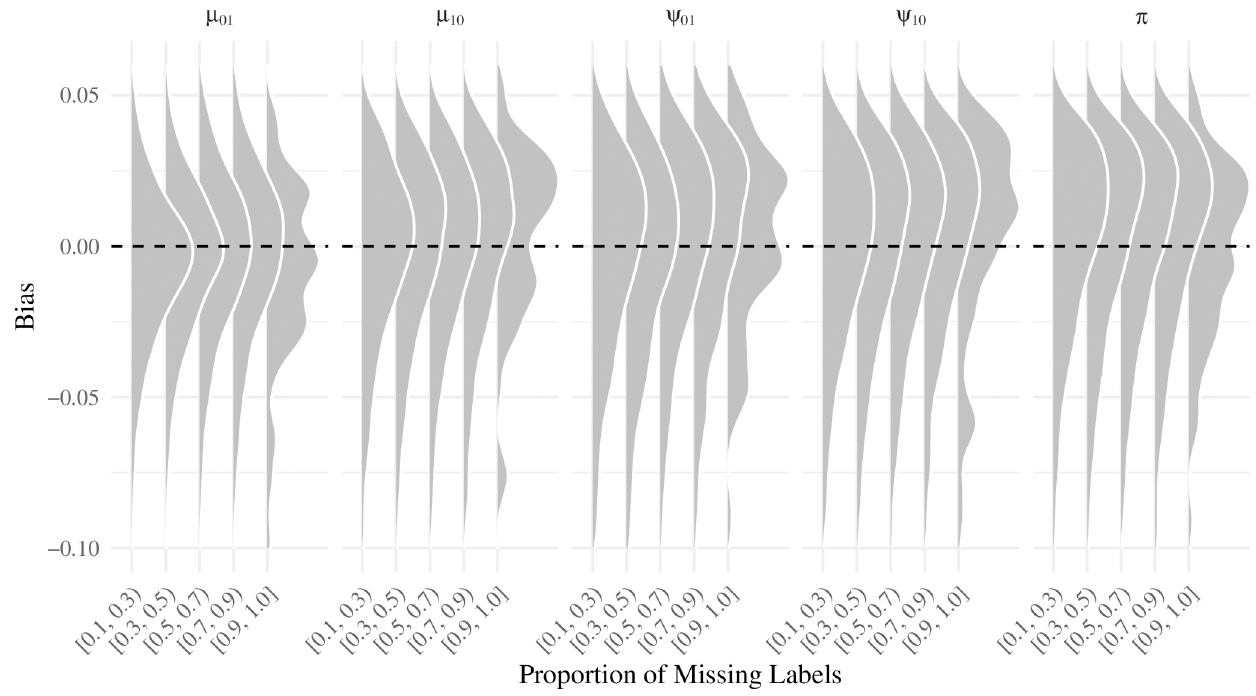
Fig 12. Empirical bias distribution for the partially annotated scenario by parameter and proportion of missing labels.